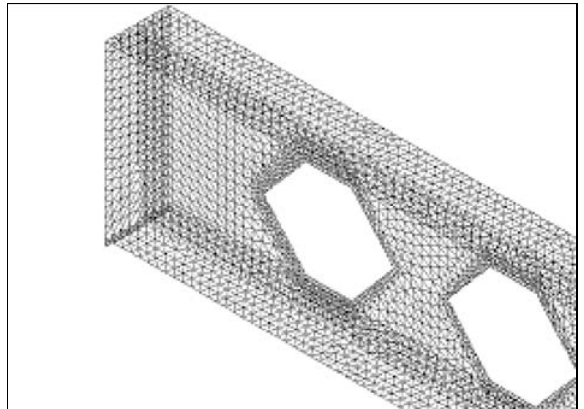
Fig. 4. Finite element model with hexagonal form of per-